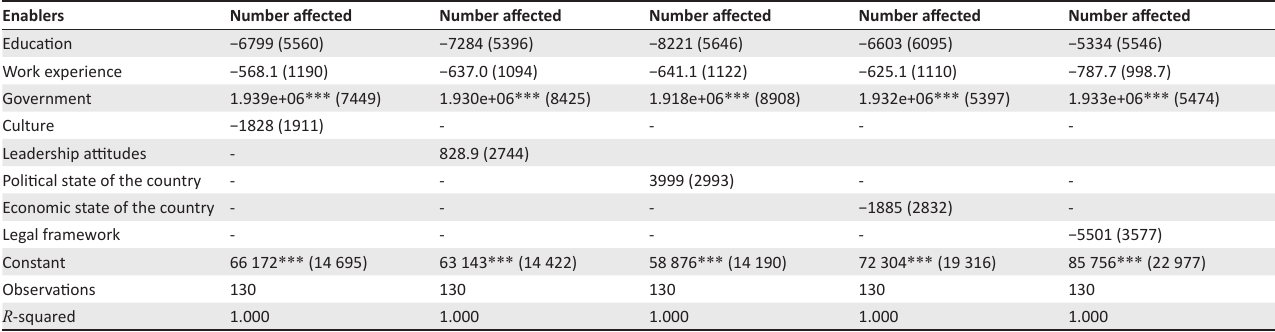
TABLE 7: The impact of enablers on number affected.